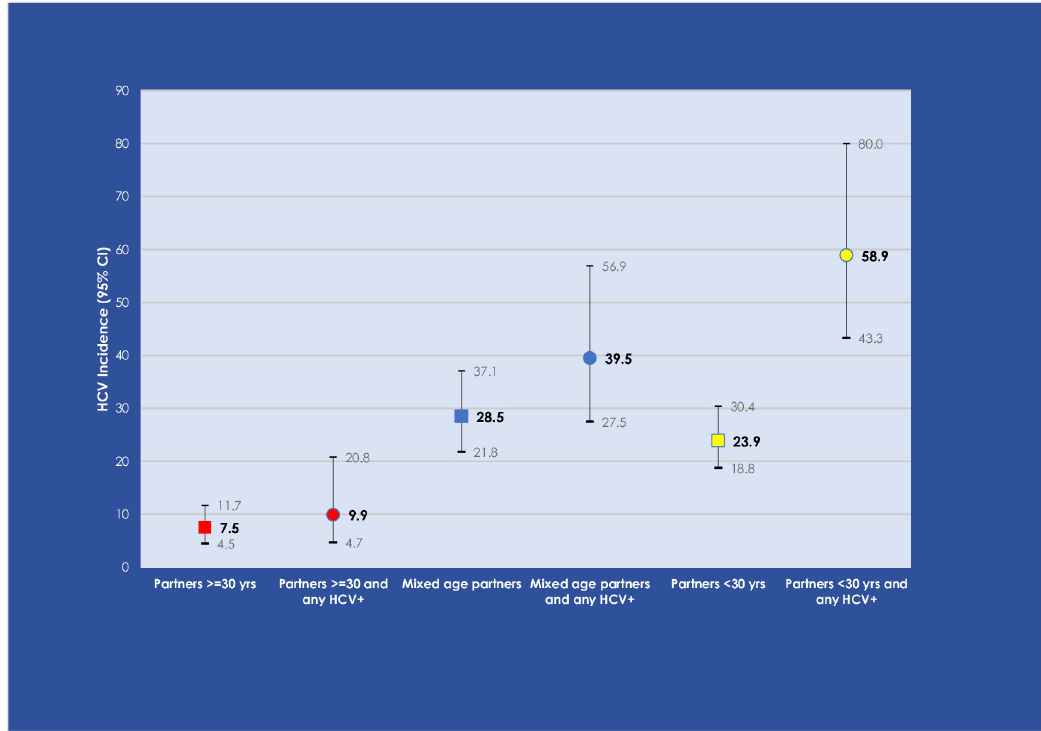
Fig 1. HCV incidence per 100/person years observation (and 95% Confidence Interval) among young people who inject drugs by injecting age and HCV serostatus partner group.